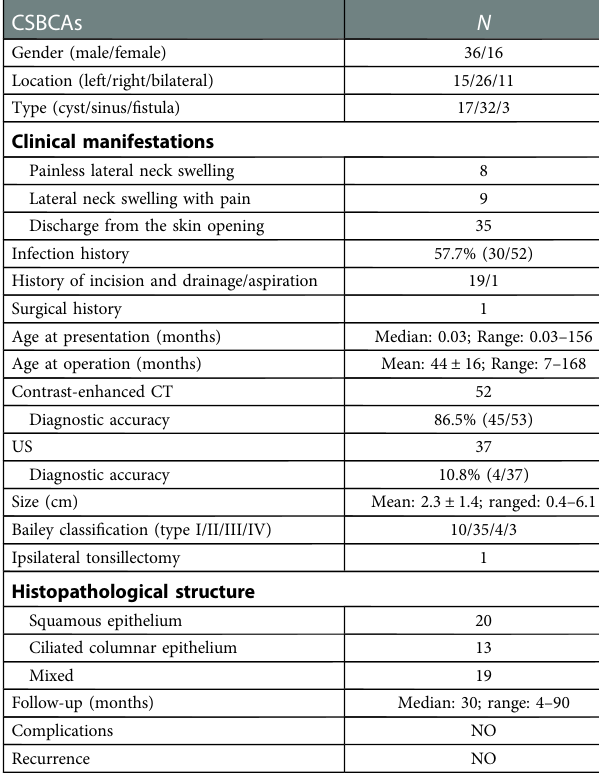
TABLE 1 Clinical summary of our patients with